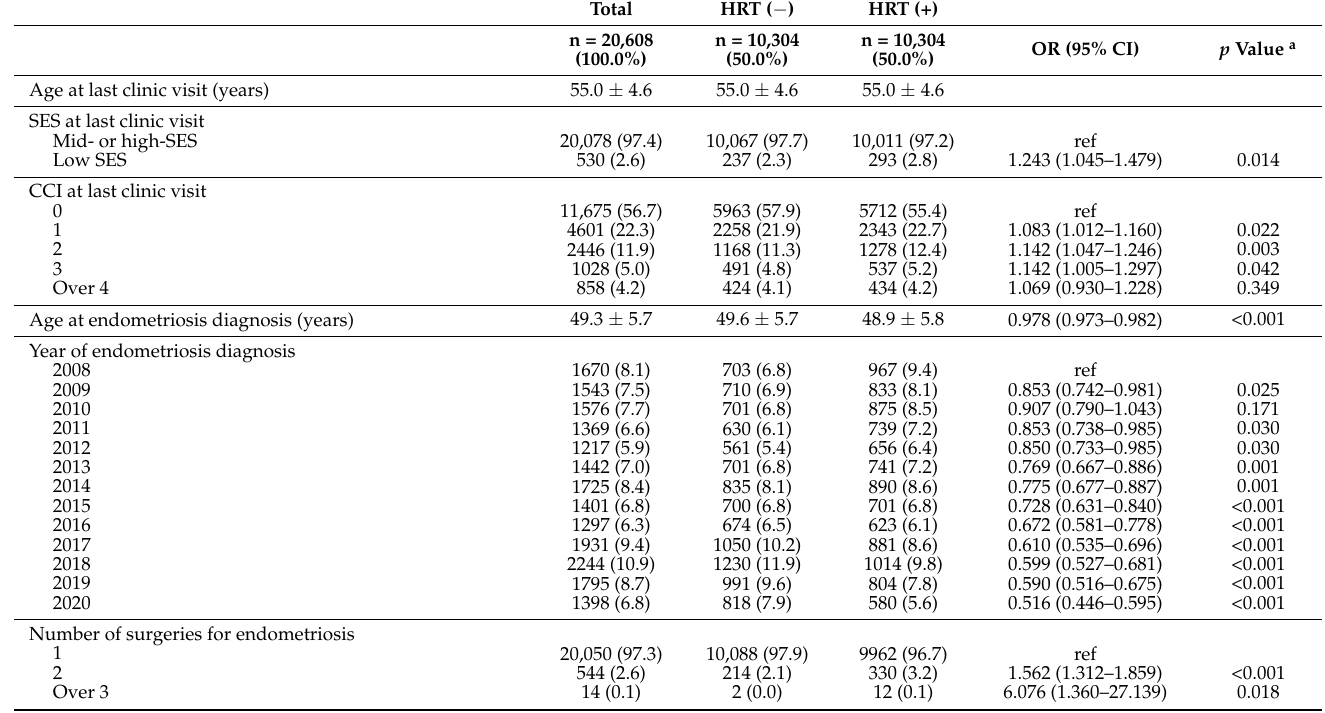
Table 1. Characteristics according to HRT in women with endometriosis (HIRA claims data